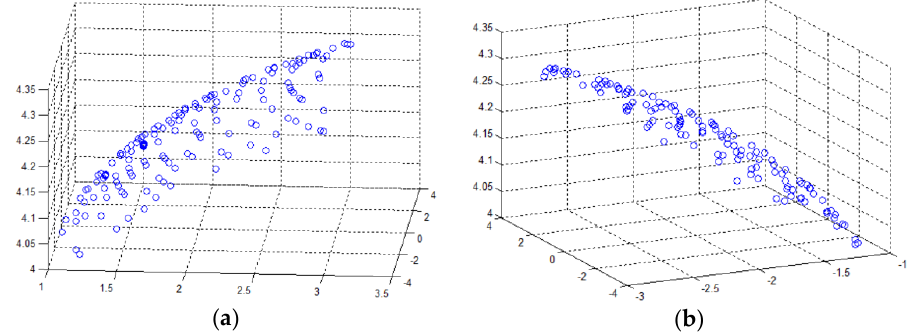
Figure 3. The coordinate distribution of voltage equivalent points at voltages of 0.71 V and −0.8 V: ( a ) at voltage of 0.71 V; ( b ) at voltage of −0.8 V .